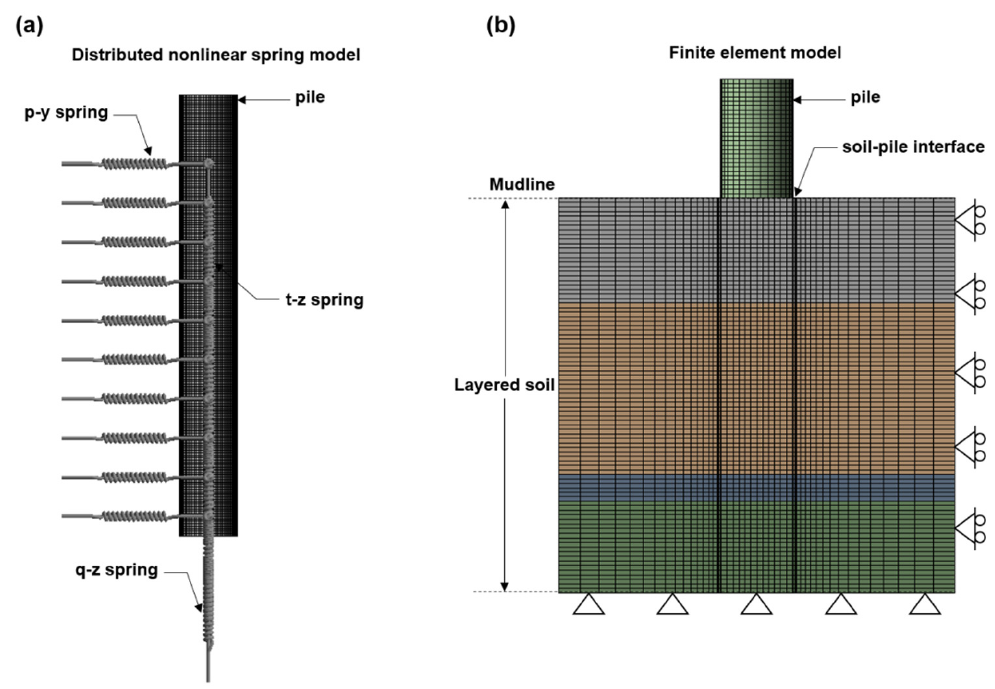
Figure 2. Soil-pile interaction of ( a ) distributed nonlinear spring model and ( b ) FE model.